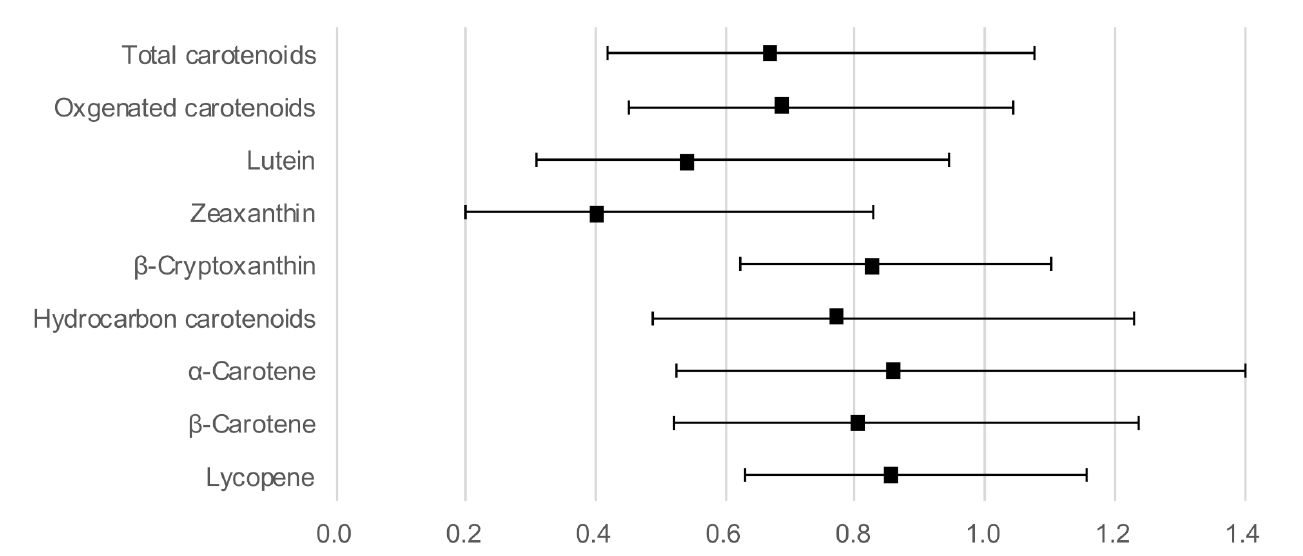
Figure 1. Odds ratios and 95% confidence intervals for a high hs-CRP level with serum carotenoid concentrations as continuous variables, adjusted for age, sex, body mass index, current smoking, regular alcohol intake, habitual exercise, and total energy